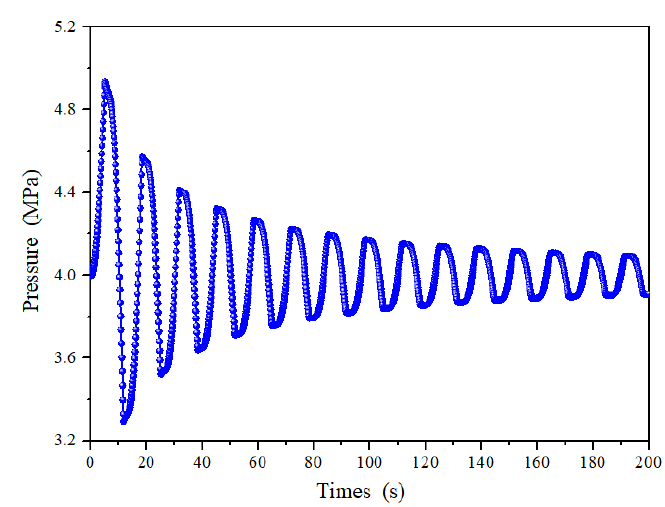
Figure 6. Pressure fluctuation at the end of the pipeline.